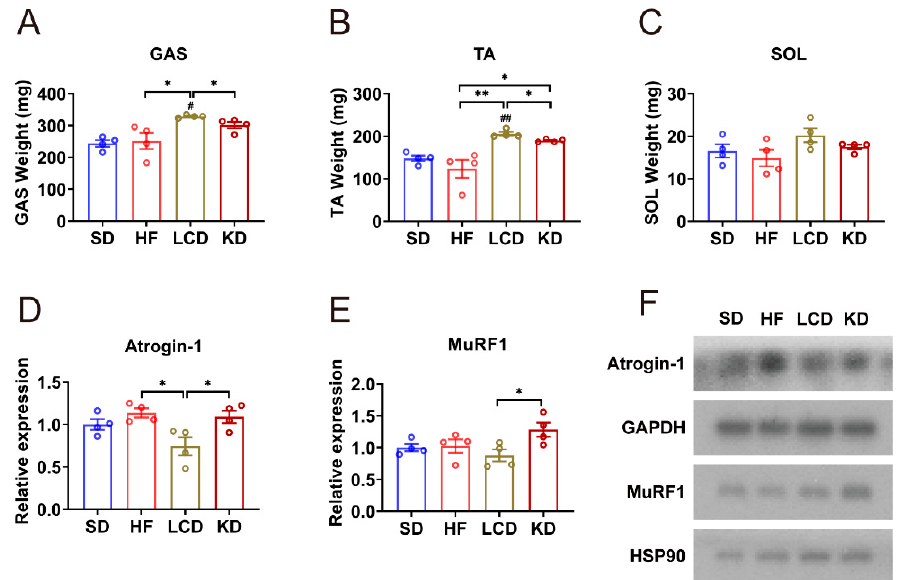
Figure 1. Low-carbohydrate diet inhibited atrophy in skeletal muscle. ( A ) GAS, ( B ) TA, and ( C ) SOL weight of mice with di ff erent treatments. ( D , E ) mRNA levels of ( D ) Atrogin-1 and ( E ) MuRF1 in the GAS muscle. ( F ) Western blots of Atrogin-1 and MuRF1 in the GAS muscle. Means ± SEM are shown. # p < 0.05, ## p < 0.01 versus the standard diet group. * p < 0.05, ** p < 0.01 di ff erences between groups. SD, standard diet; HF, high-fat diet; LCD, low-carbohydrate diet; KD, ketogenic diet.